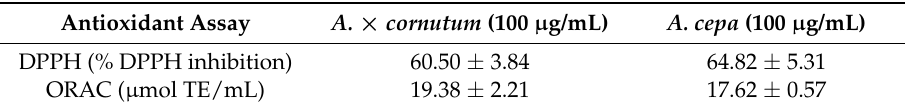
Table 2. Antioxidative potential of A. × cornutum and A. cepa methanolic extracts determined by DPPH and ORAC